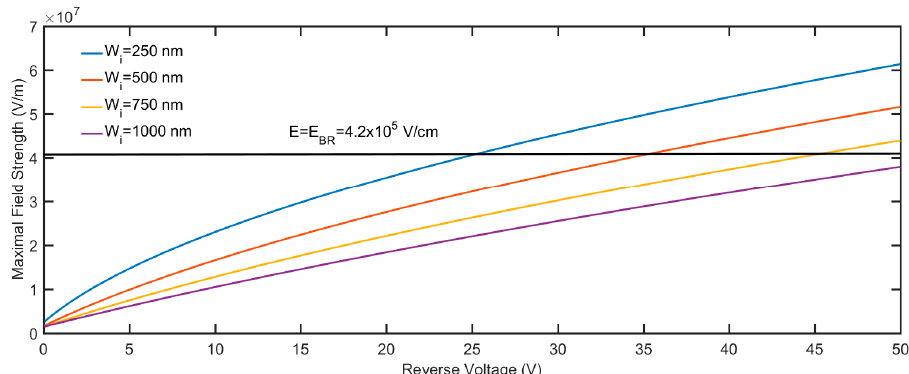
Figure 12. The maximum electric field strength at various reverse voltages.